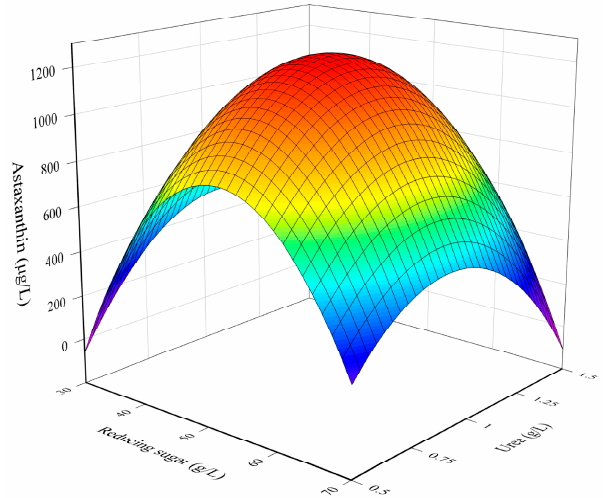
Figure 1. Combined effect of reducing sugar concentration and urea concentration on the astaxan- thin yield.